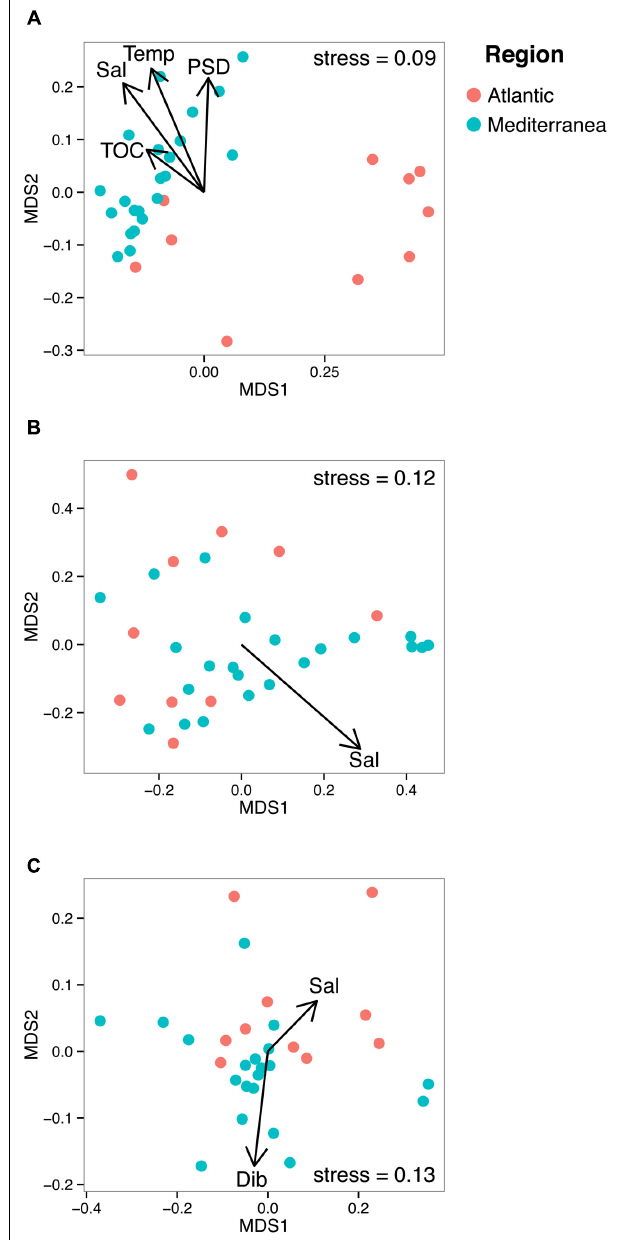
FIGURE 4 | Non-metric multidimensional scaling plots of bacterial (A), archaeal (B), and eukaryotic (C) UNIFRAC matrices. The arrows represent the significant environmental variables fitted as vectors using the envfit function of the vegan package. Temp stands for temperature, Sal for salinity and Dib for Dibenz[ a,h